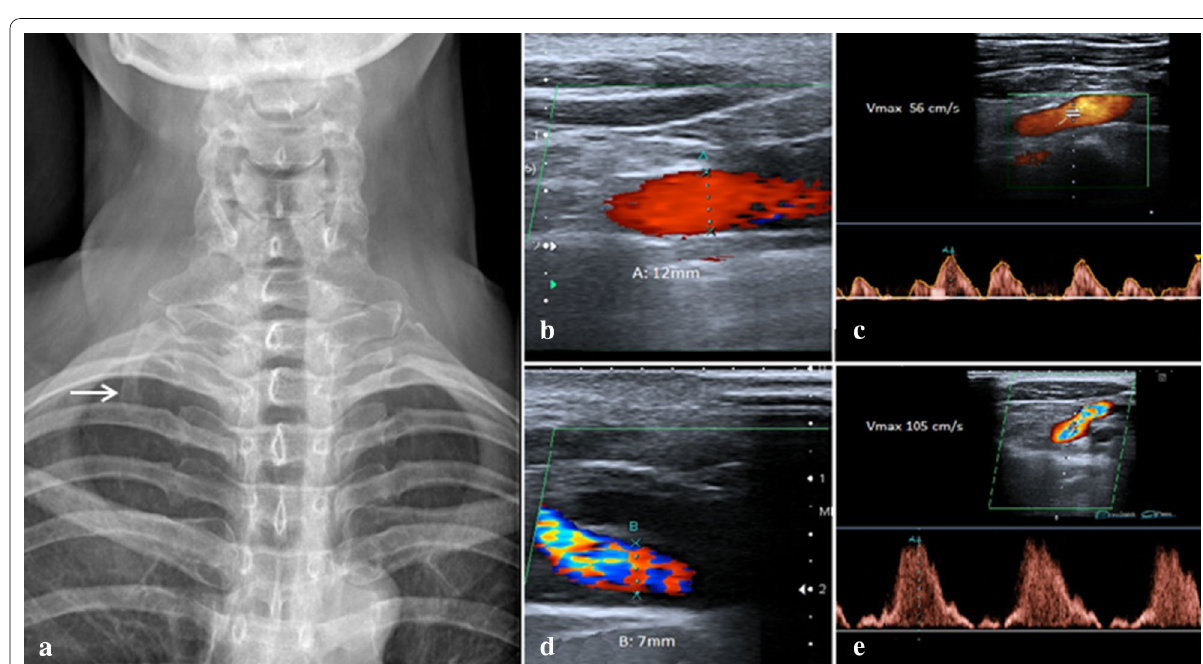
Fig. 4 a Standard radiography showing a cervical rib on the right (arrow). b Color Doppler US examination, performed with lowered arms, shows a regular diameter (12 mm) and a regular flow-C of the right subclavian artery. d Color Doppler US examination with raised arms shows artifacts due to turbulent flux. E: Duplex Doppler US shows increase in peak speed (105